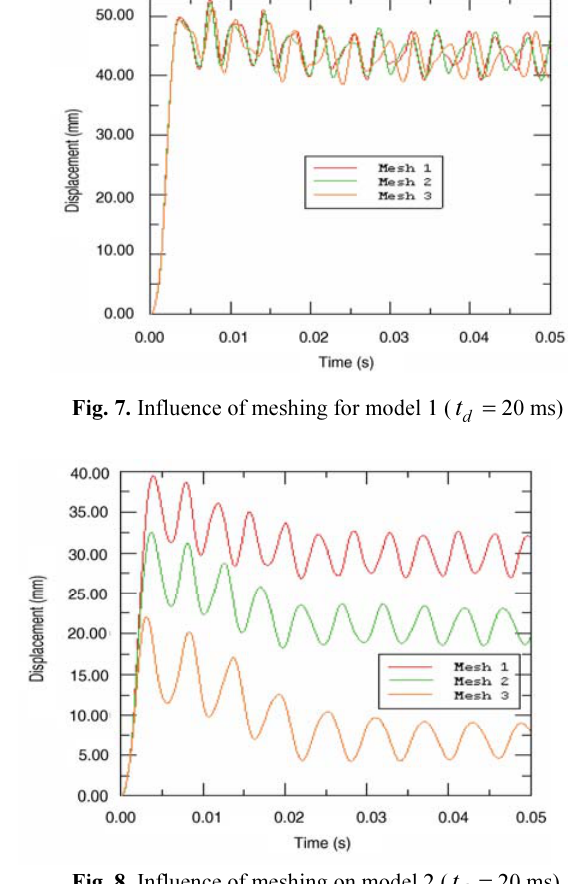
Fig. 8. Influence of meshing on model 2 ( d